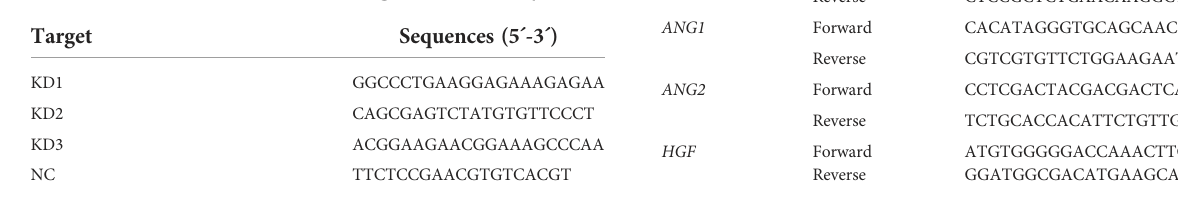
TABLE 1 Three COX4I2 siRNA and NC (Negative Control) sequences.